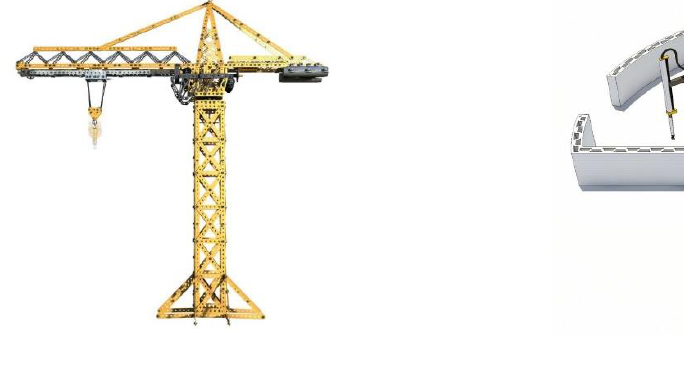
Source: meccano gru Apis